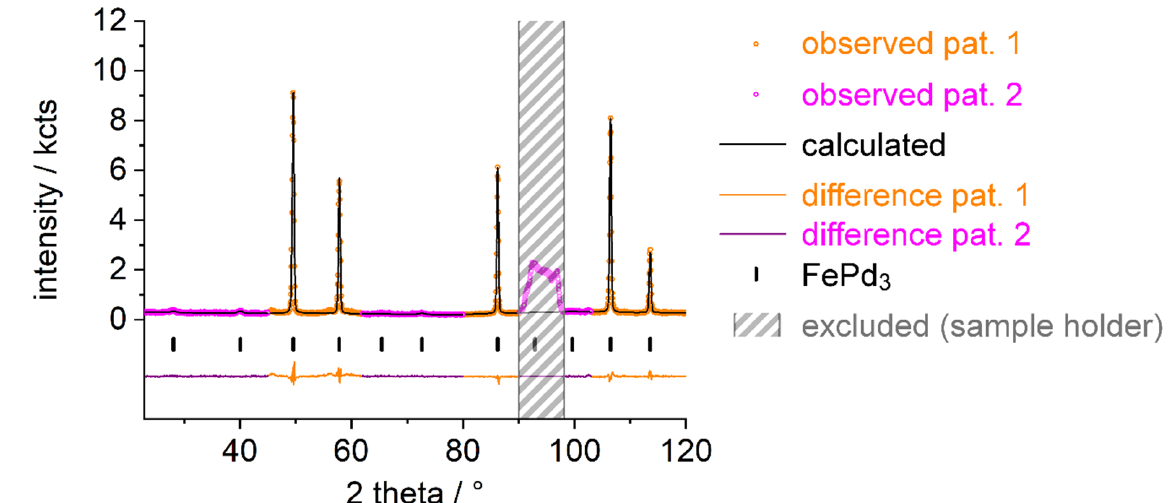
Figure A22. Rietveld refinement of the crystal structure of FePd 3 D 0.065(11) (for details, see tenth row in Tables A8 and A9) based on neutron powder diffraction data (NUMOR 131791 [21], λ = 186.80(2) pm, D20 ILL, Grenoble) in a single-crystal sapphire cell at 519(2) K and 8.25(1) MPa deuterium pressure using FullProf [24].